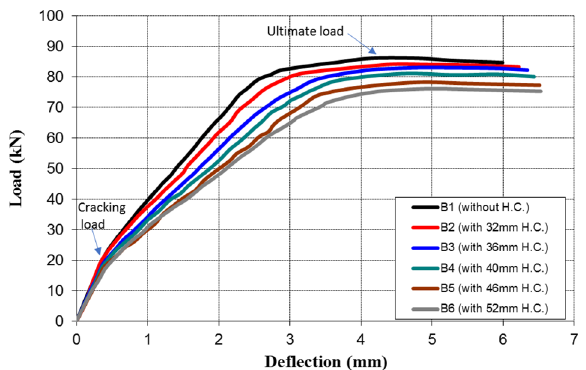
Fig. 9 Influence of longitudinal void diameter on load–deflection behavior of SCC beams